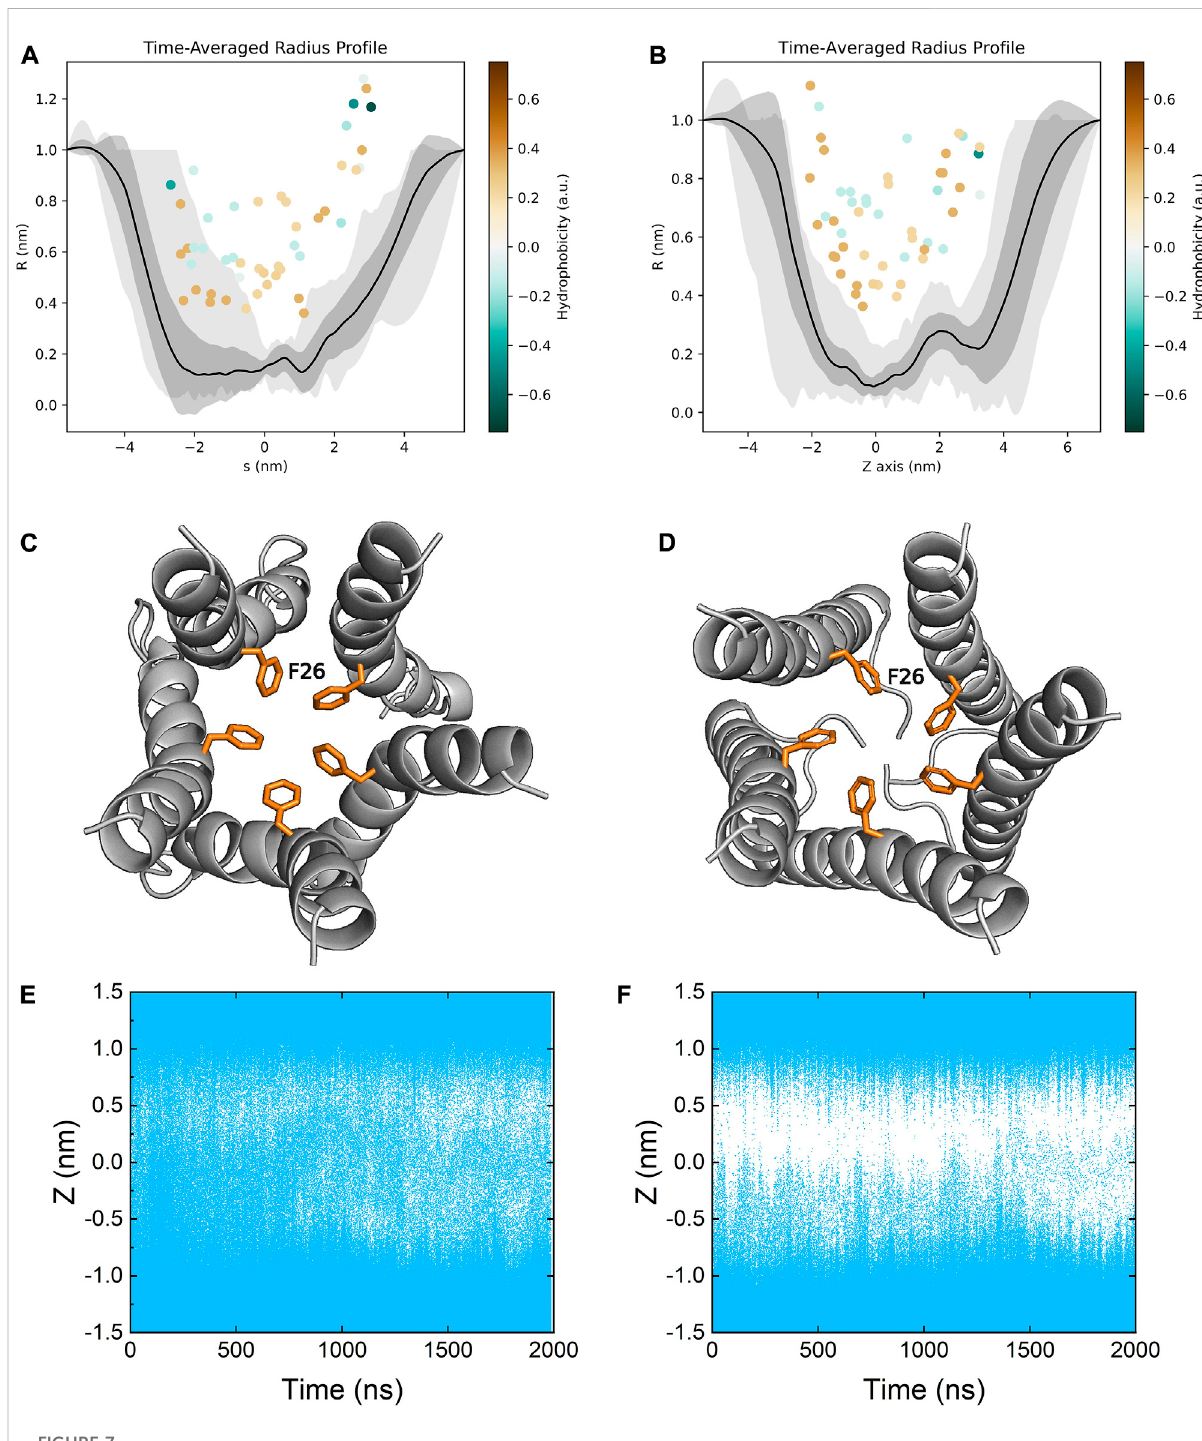
FIGURE 7 Time-averaged pore radius pro fi les of (A) the homology model and (B) the re fi ned model. The grey shaded areas correspond to the one-sigma (dark gray) and two-sigma (light gray) con fi dence intervals. The pore lining residues (facing the channel more than 50% of the time) are indicated as dotscoloredbytheirhydrophobicity.TopviewofthebottleneckresiduePHE26inthechannelof (C) thehomologymodeland (D) there fi nedmodel. Pore hydration pro fi les of (E) thehomology model and (F) the re fi ned model. Coordinates of water molecules alongthe z axiswere plotted as a function of time. Each water molecule was represented by a blue